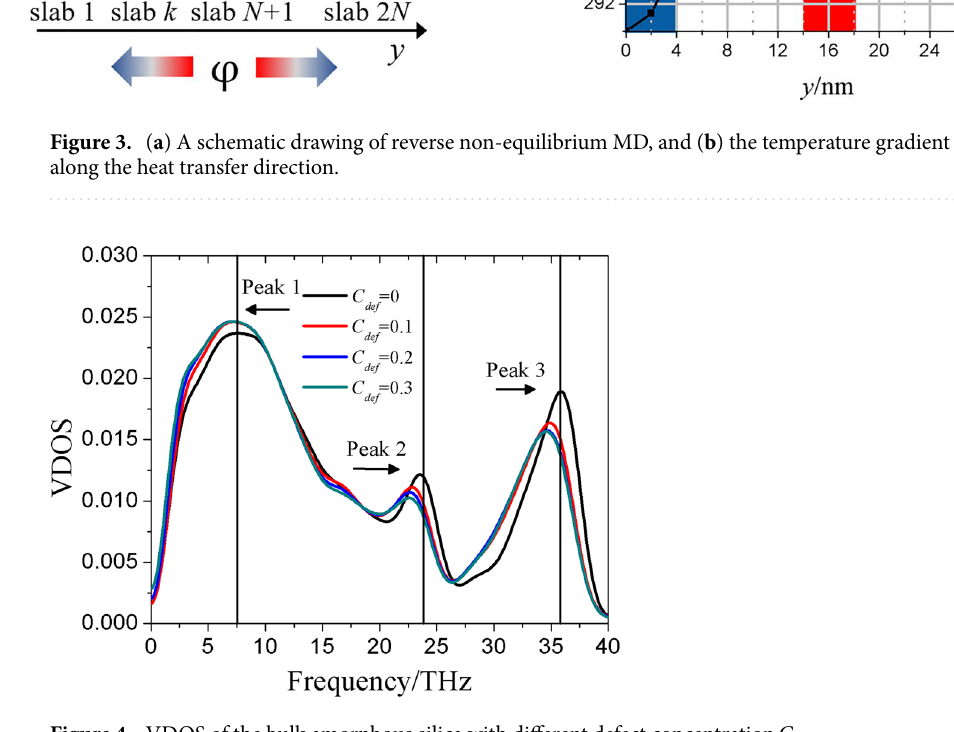
Figure 4. VDOS of the bulk amorphous silica with different defect concentration C def